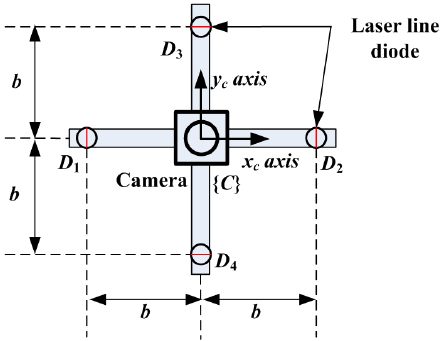
, D , D and D . 1 2 3 4